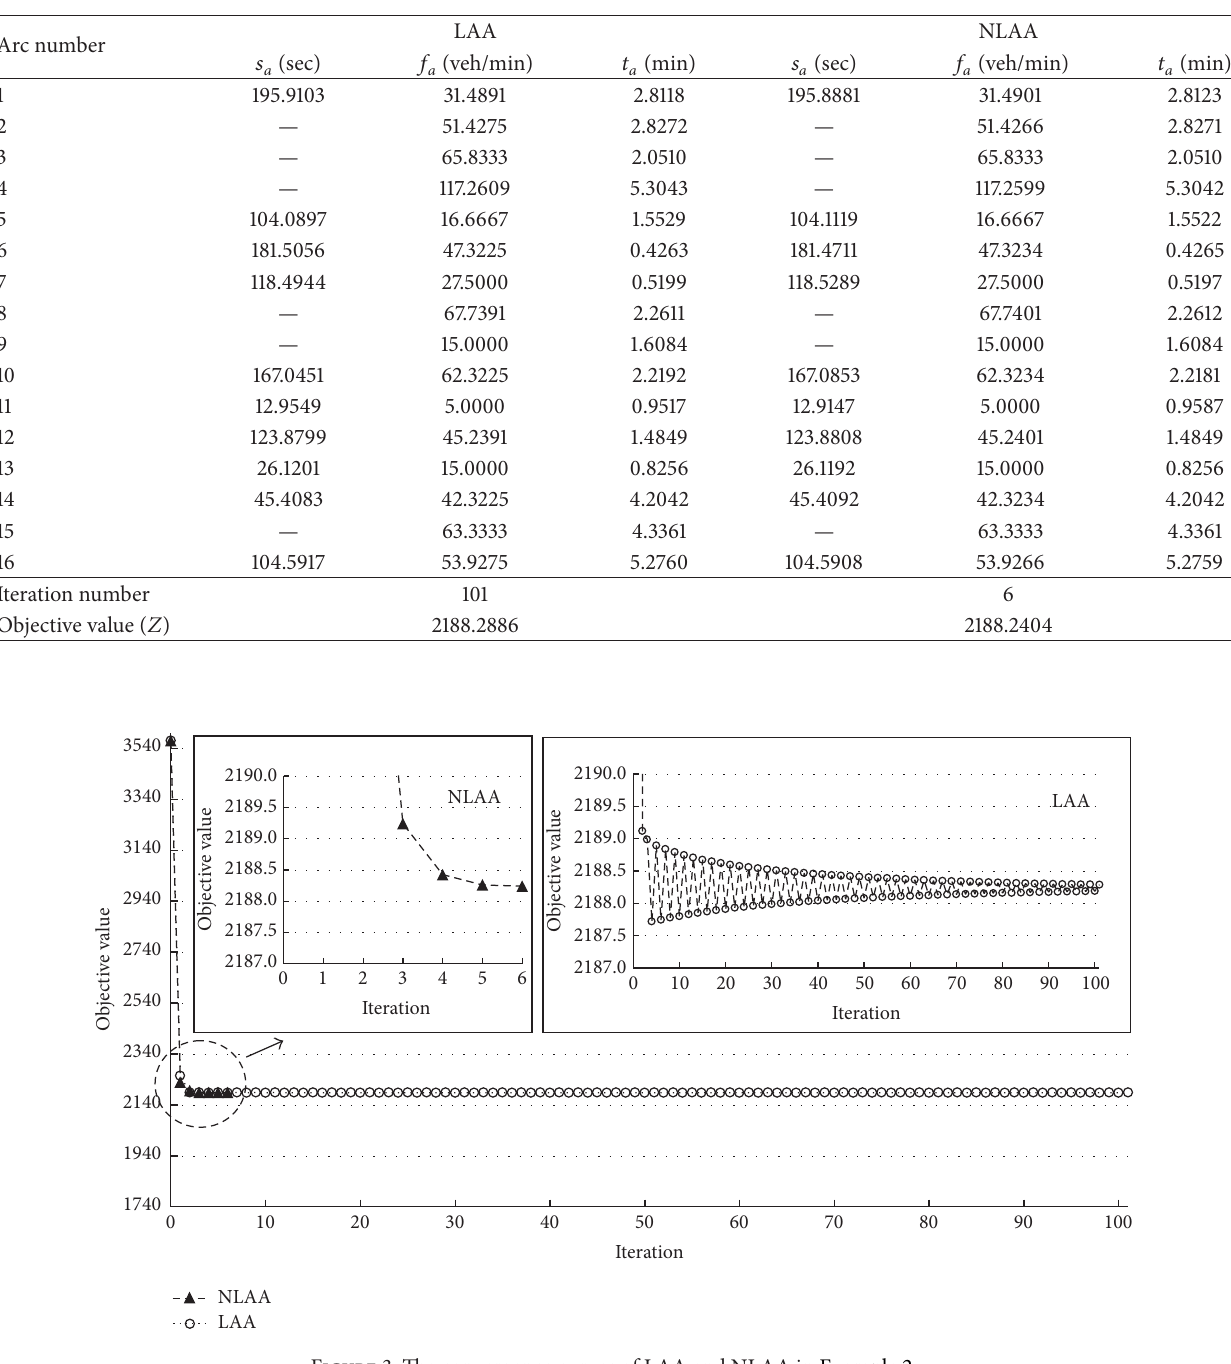
Table 5: Computational results of LAA and NLAA in Example 2.